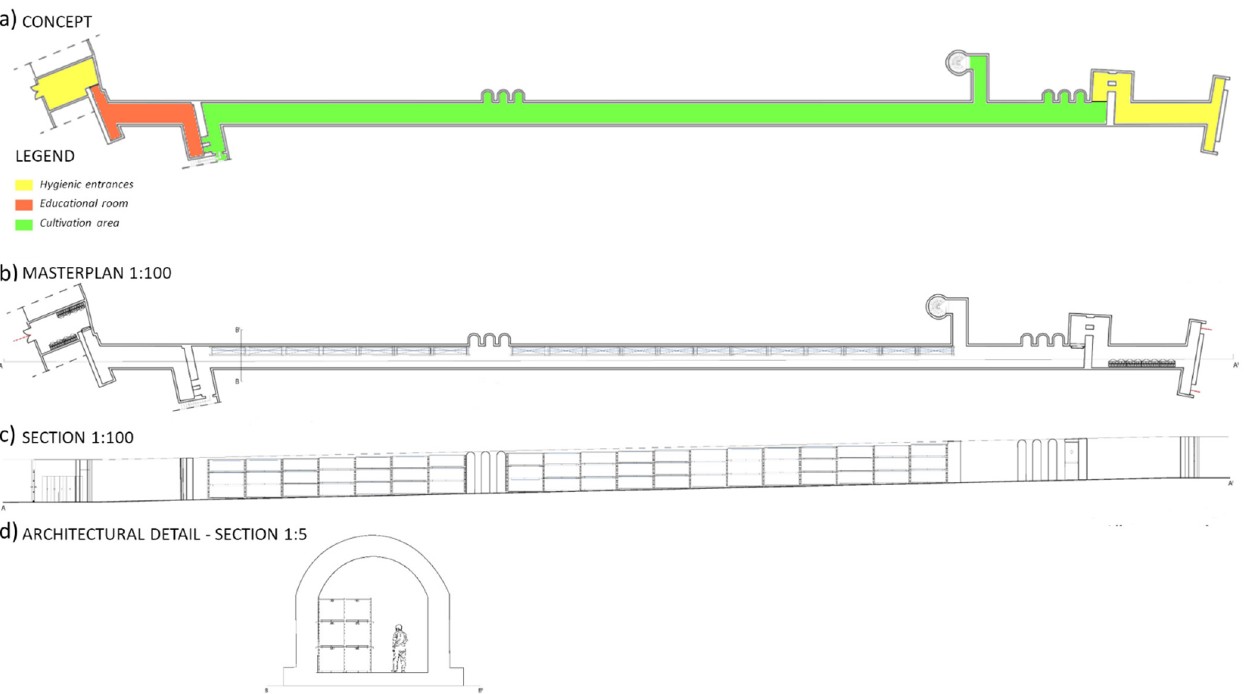
Figure 9. Representation of the division of the tunnel into four sections: ( a ) the concept, ( b ) the master plan, ( c ) the section view, and ( d ) an architectural detail of the tunnel with the representation of a multilayer rack system.